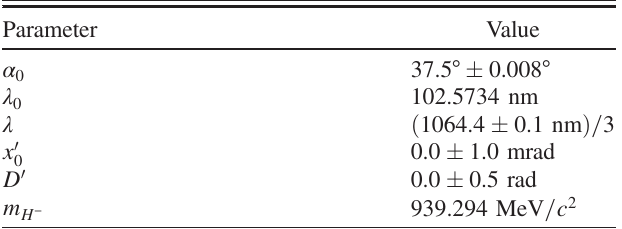
TABLE I. Parameters relevant to the LACE energy in the SNS